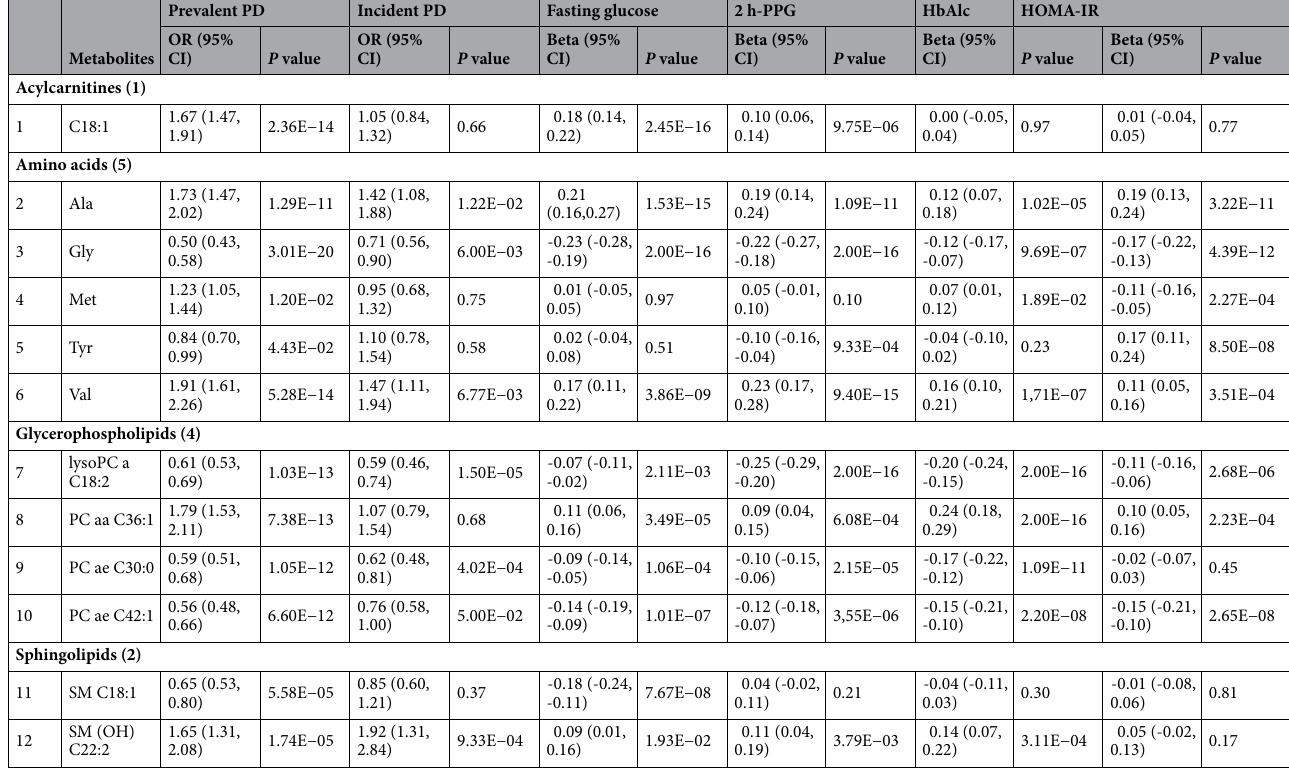
Table 2. Association of stepwise regression selected 12 metabolites with prevalent and incident PD, as well as fasting glucose, 2 h-PPG, HbA1c, and HOMA-IR at baseline ( P < 0.05). Odds ratio (OR) and 95% confidence interval (CI) estimates provided from logistic regression and Beta (beta coefficient; effect size) from linear regression in the normalized metabolites.